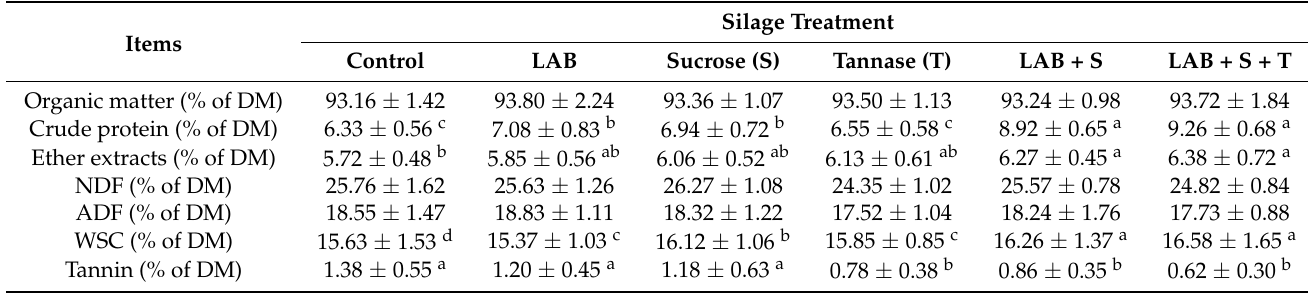
Table 6. Chemical composition of defective banana silage after 45 d of